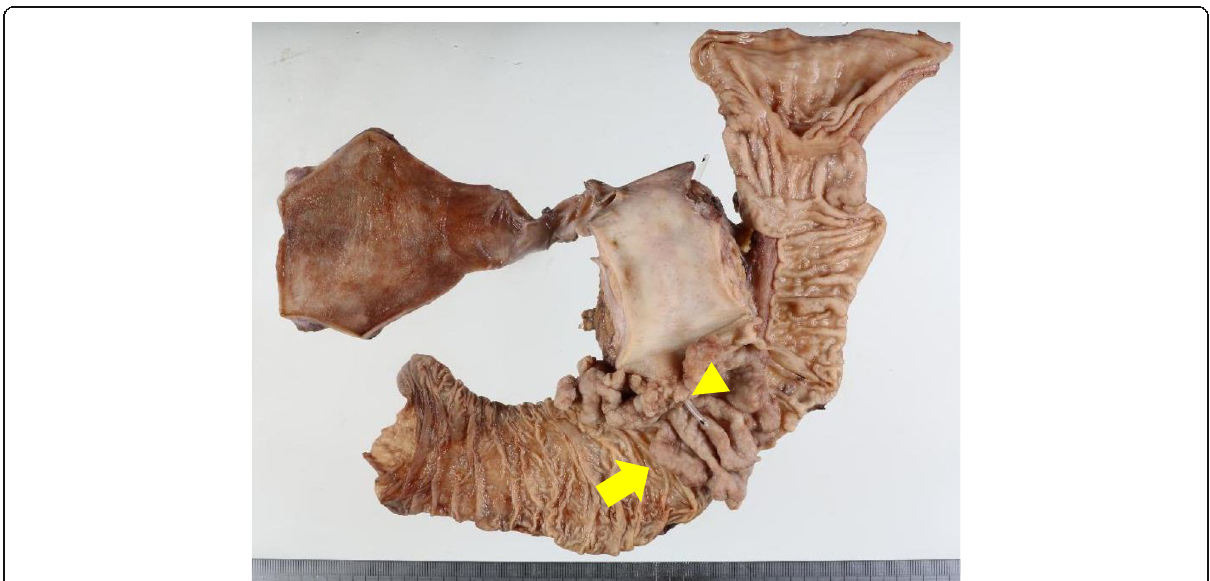
Fig. 3 The resected specimen was a large villous tumor measuring 80 × 55 mm (arrow), arising around the orifice of the duodenal papilla